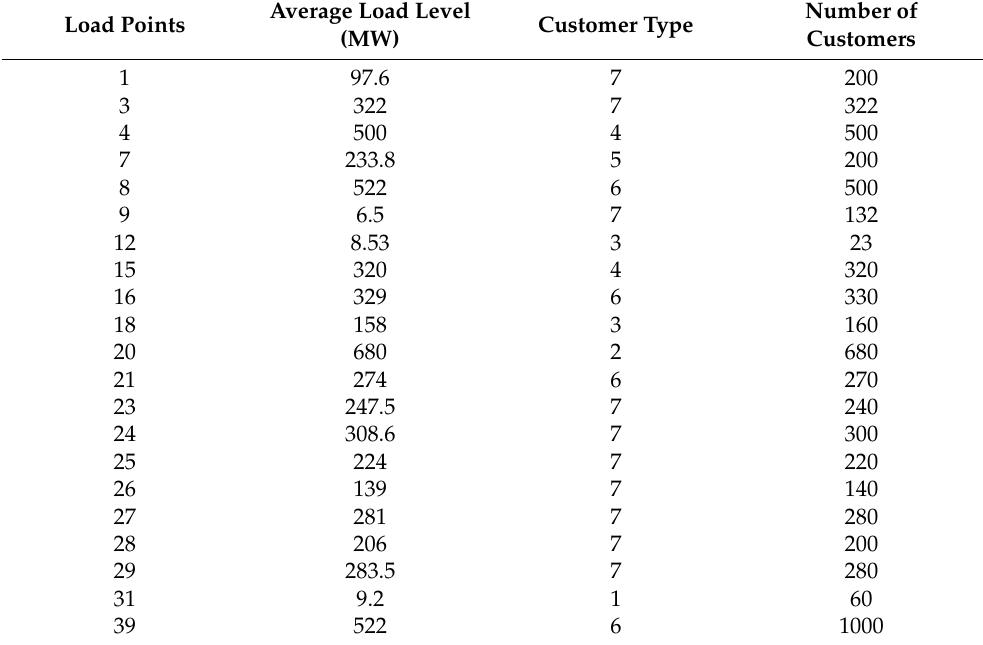
Table A1. An IEEE 39 bus system load and customer data [45].